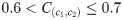
Performance comparison for REMAP (green), PRW (blue), and NRLMF (orange).NT2 (2 known targets per chemical) datasets used for varying number of ligands (A) and chemical structural similarity (B). Performance measurement explained in the measuring prediction accuracy of REMAP by TPR vs. cutoff rank section. (A) Performance comparison on the datasets with varying number of ligands per protein. For example, the x-axis of L11to15 means that the proteins of interest have between 11 and 15 known chemicals to bind. (B) Performance comparison on the datasets with the ranges of chemical structural similarity of the tested chemicals to the trained chemicals. For instance, the x-axis of Tc0.6to0.7 means that for the tested chemicals, at least one trained chemical was found such that 0.6<C(c1,c2)≤0.7 and no trained chemical was found in greater similarity than 0.7. All TPR values are based on 10-fold cross validation. Error bars represents s.e.m. Asterisks represents statistical significance based one t-test of the 10 TPR values (* for p < 0.05, ** for p < 0.001).